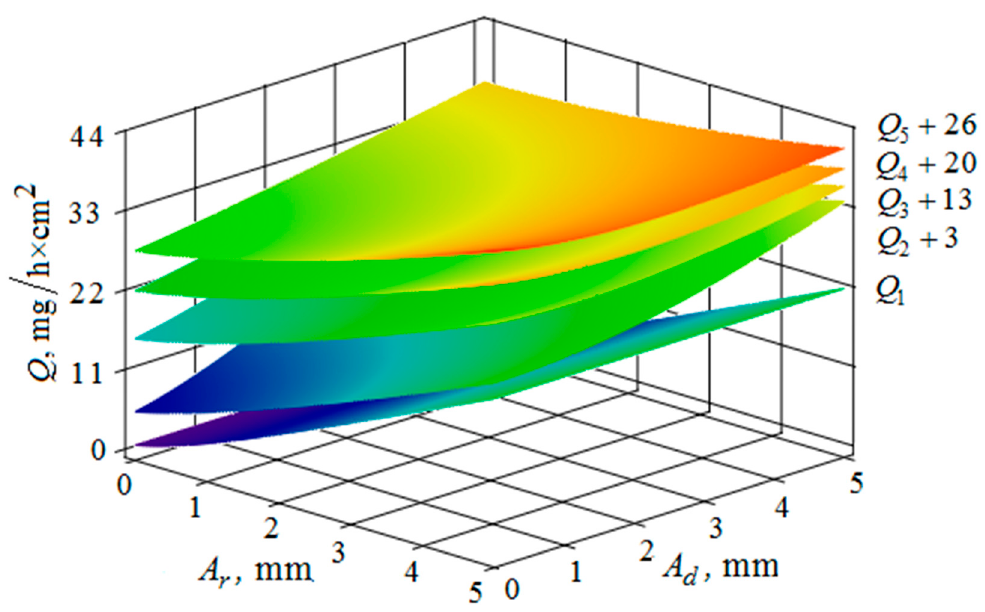
Figure 16. Dependence of the metal removal Q , mg/h·cm 2 on the amplitudes of oscillations Ar , mm and Ad , mm of the reservoir working surface and the processed part for different values of frequencies of oscillations of the part surface: ( 1 Q , 2 Q , 3 Q , 4 Q , 5 Q —metal removal at d ω = 0;16; 34; 52; 70 , Hz); the oscillation frequency r ω of the reservoir working surface is 50 Hz.